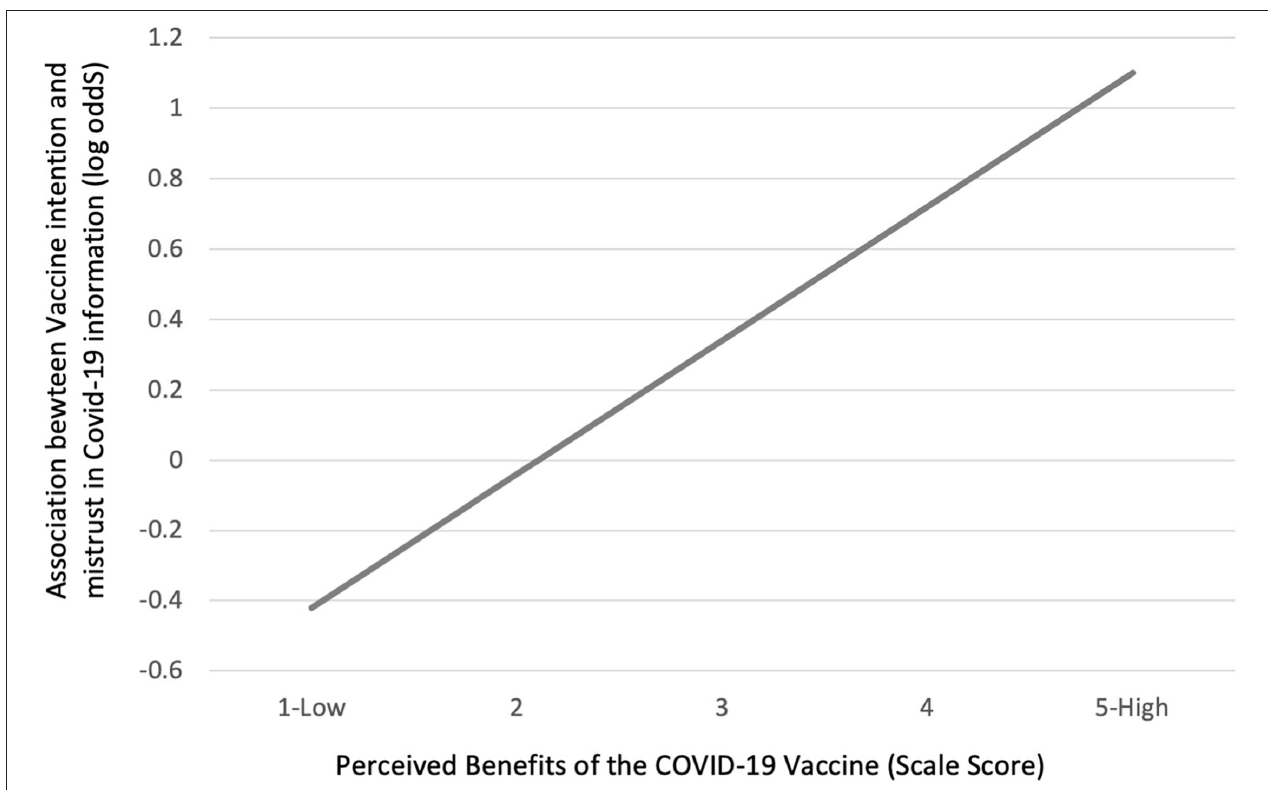
FIGURE 2 | Interaction effects: adjusted associations between intentions to be vaccinated and level of mistrust in COVID-19 information (log odds) across levels of perceived benefits of the vaccine (1–5).